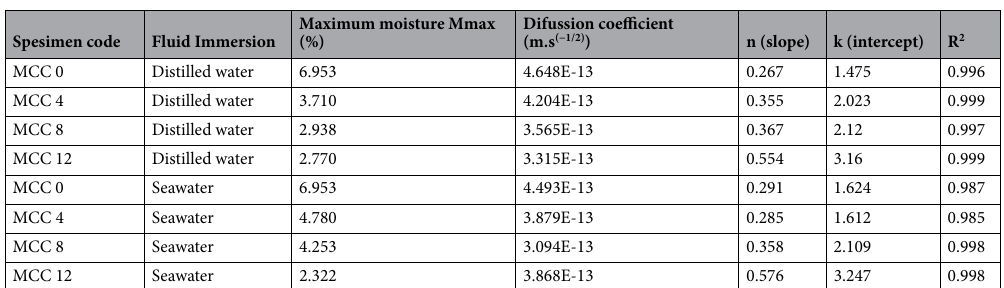
Table 6. Water absorption parameter and difussion coefficient values for all MCC composite.